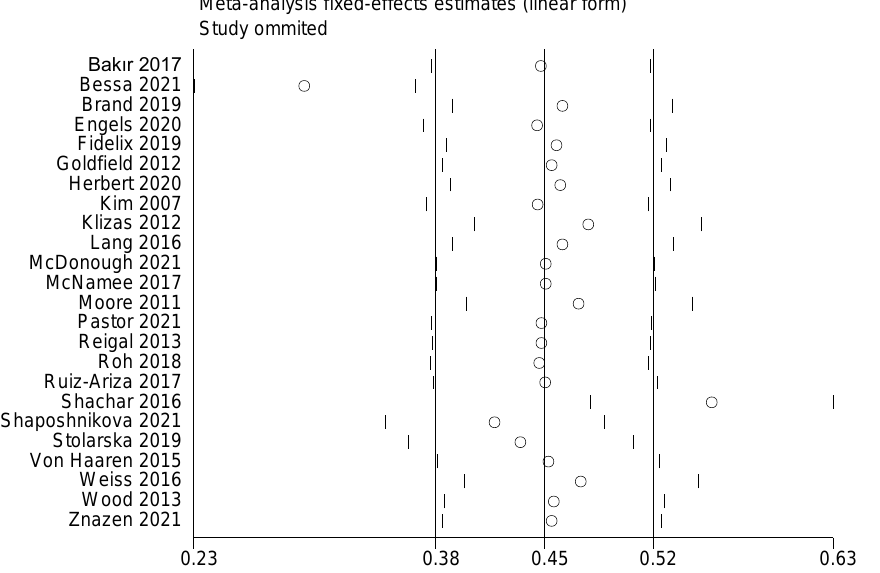
Figure 6. Sensitivity analysis of the association between PA and positive emotions in children and adolescents [30 – 53].